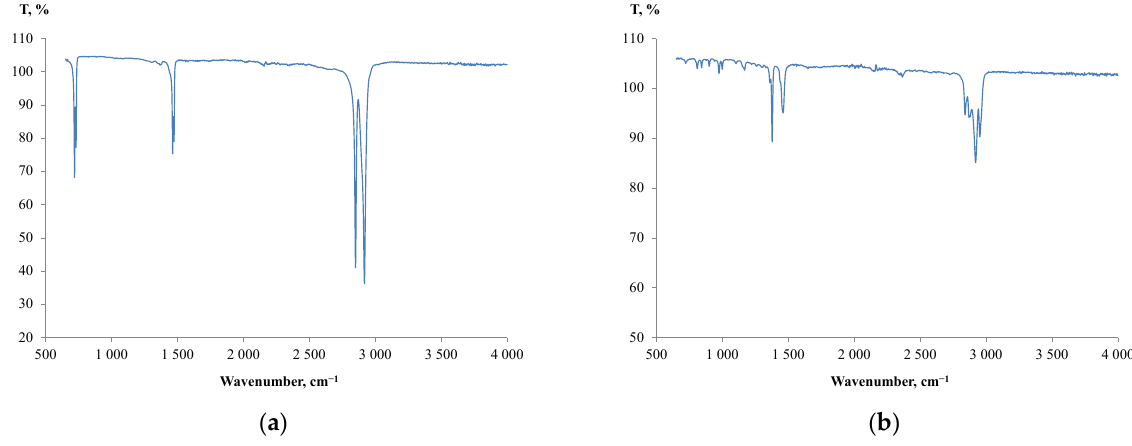
Figure 4. IR spectra produced from the unmarked plastic particles: ( a ) LDPE; ( b ) PP. A small absorption band at 1377 cm −1 (Figure 4a) indicated that a majority of un- marked particles were produced from low-density polyethylene (LDPE) [54,55], and a few were made of polypropylene (PP) (Figure 4b). The results of plastic identification and the measured densities of the particles were consistent with the literature data for HDPE (0.940–0.970 g/cm 3 ), LDPE (0.910–0.940 g/cm 3 ) and PP (0.89–0.92 g/cm 3 ) [56]. To summarise, the bottle caps were of irregular shape with differences in density.